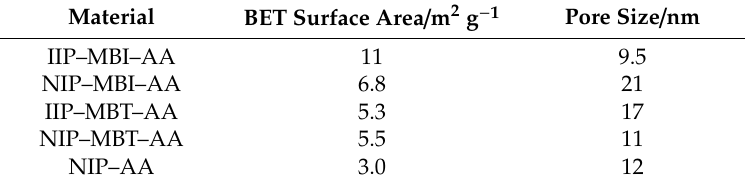
Table 2. Calculated Brunauer–Emmett–Teller (BET) surface area, total pore volume and average pore size.